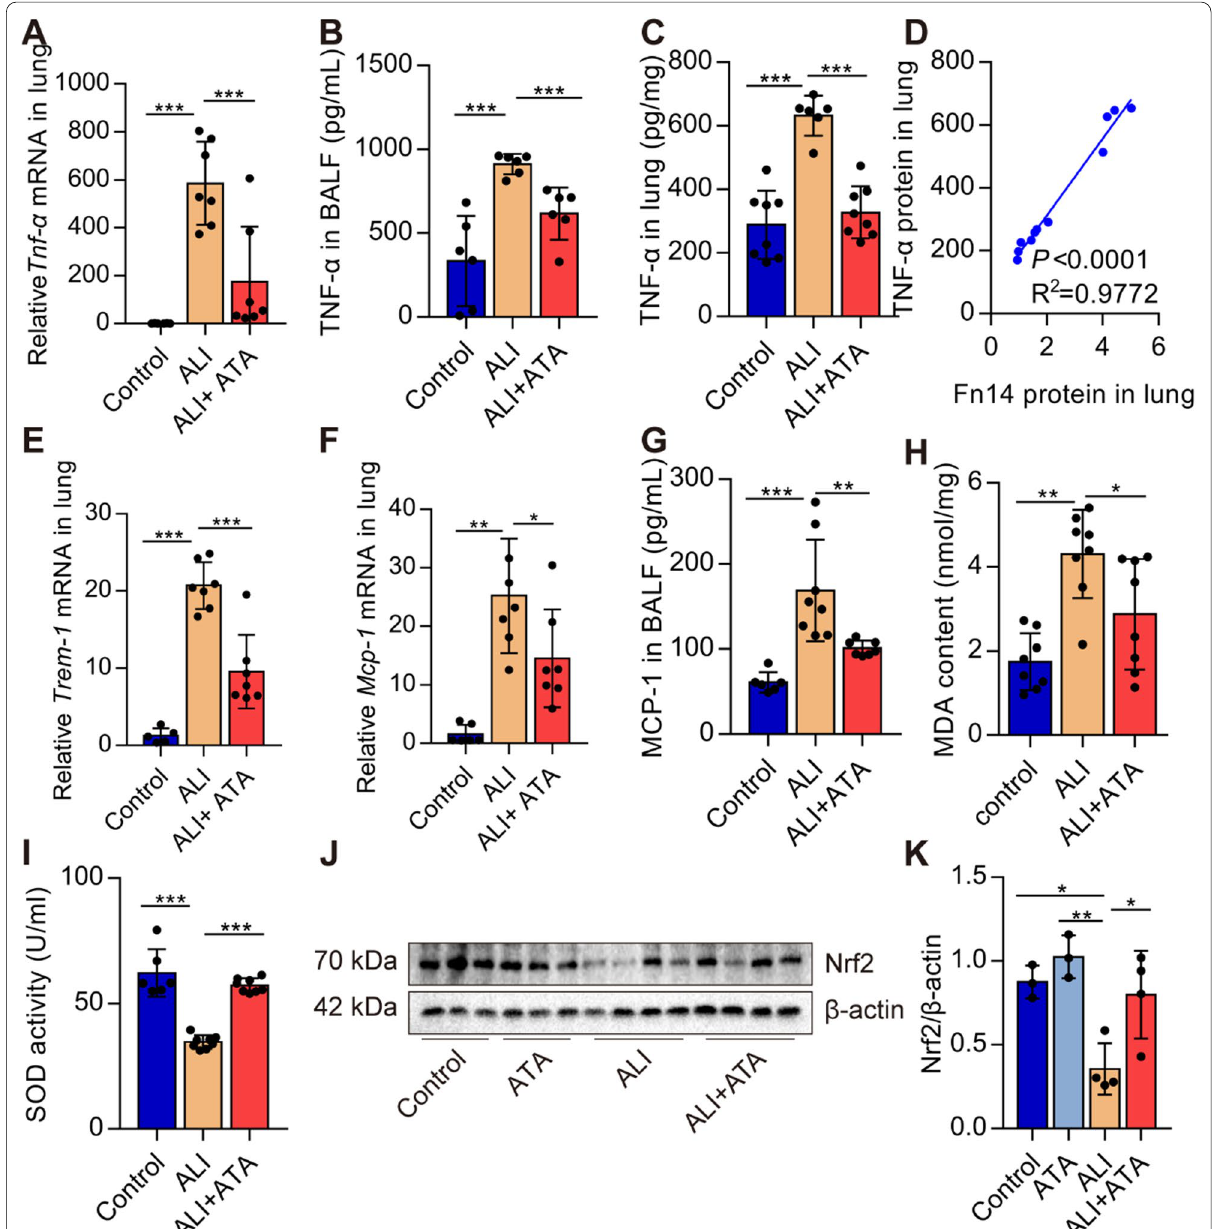
Fig. 3 Blockade of Fn14 by ATA reduces the inflammatory responses and oxidative stress in ALI mice. C57BL/6J mice were treated with saline or ATA (20 mg/kg). One hour later, mice were given saline or LPS (5 mg/kg, i.t. ). A–C Twelve hours later, TNF‑α mRNA and protein levels were determined by real‑time PCR and ELISA ( n 6–9). D The linear associations between the expression of Fn14 protein and TNF‑α protein were analyzed with = Pearson correlations analysis. E The expression of Trem-1 mRNA was determined by real‑time PCR ( n were determined by real‑time PCR and ELISA ( n 6–8). H The content of MDA in the lungs was determined ( n = tissue was determined ( n 6–8). J , K The protein expression of Nrf2 in the lungs was determined by Western blot ( n = as the mean SD. Differences among multiple groups were performed using ANOVA. Tukey’s test was used as a post hoc test to make pair‑wise ± comparisons. * P < 0.05, ** P < 0.01, and *** P <